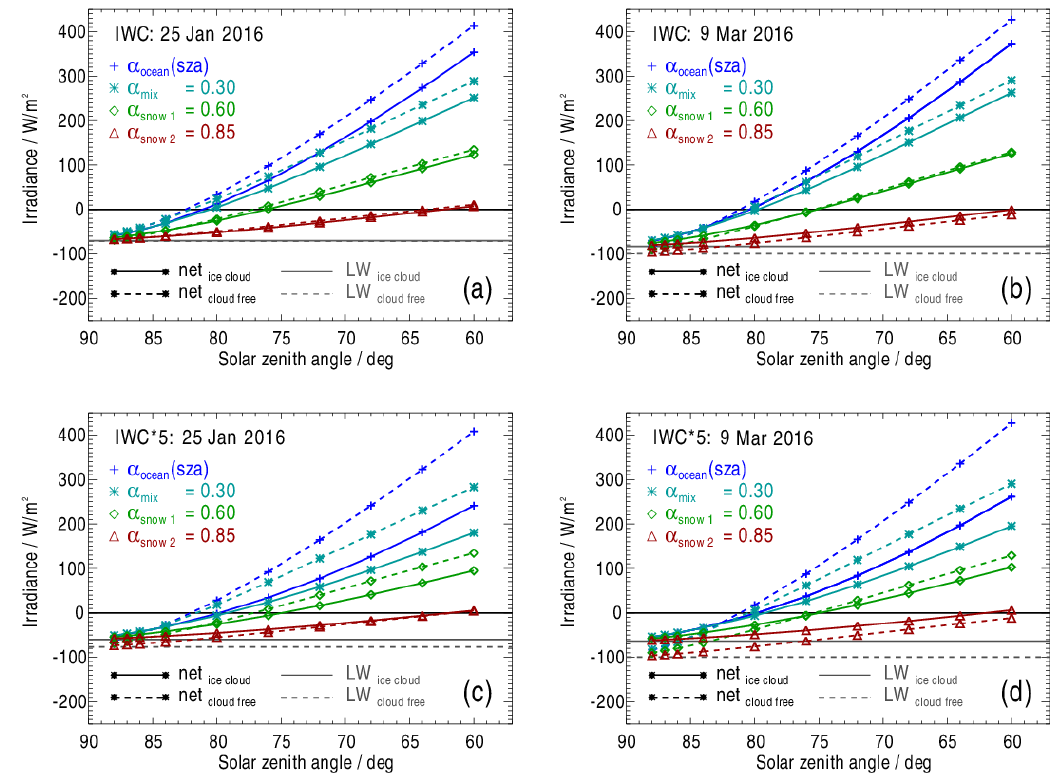
Figure 9. The same as Fig. 8 but for irradiance at the bottom of the atmosphere